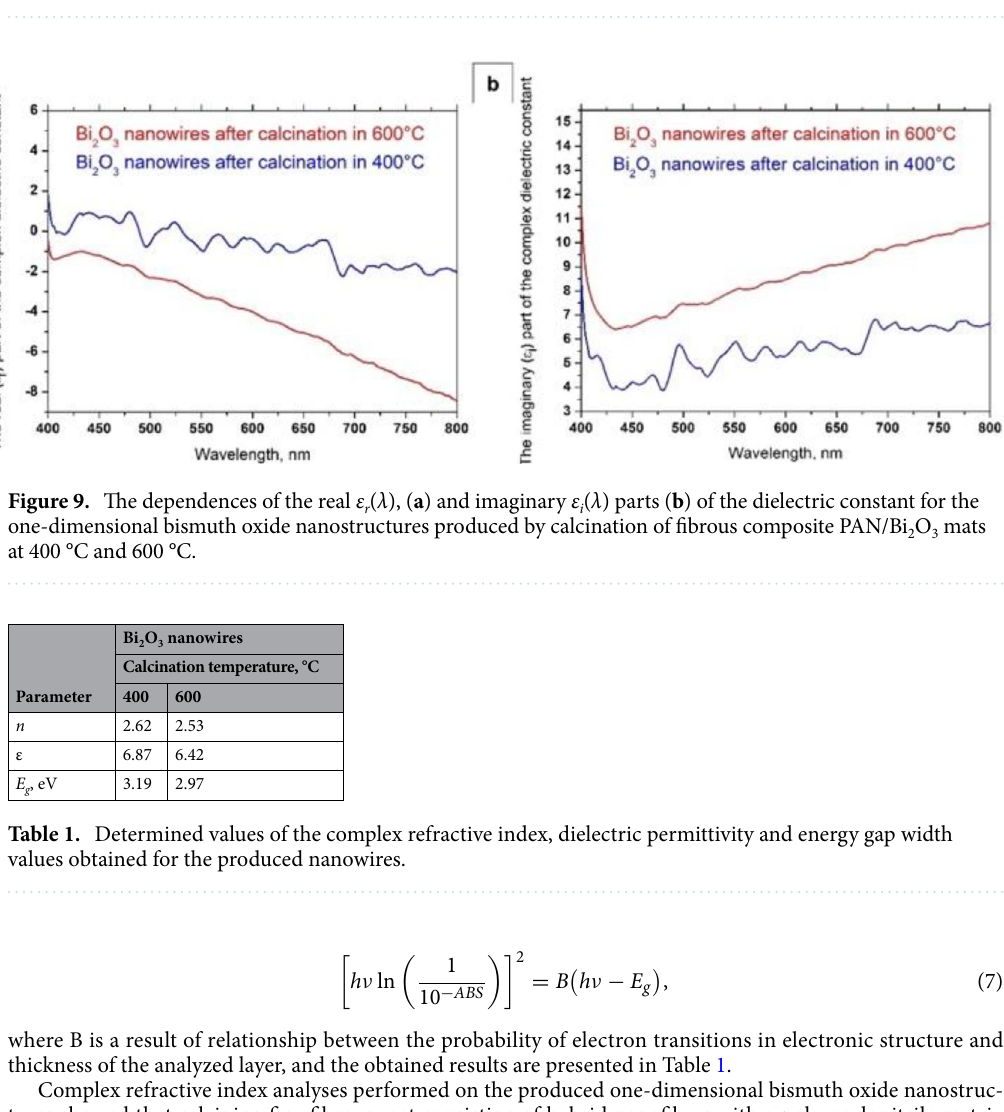
Figure 8. The dependences of the real n ′ ( λ ) ( a ) and imaginary k ( λ ) parts ( b ) of the refractive index determined for the one-dimensional bismuth oxide nanostructures produced by calcination of fibrous composite PAN/Bi 2 O 3 mats at 400 °C and 600 °C.